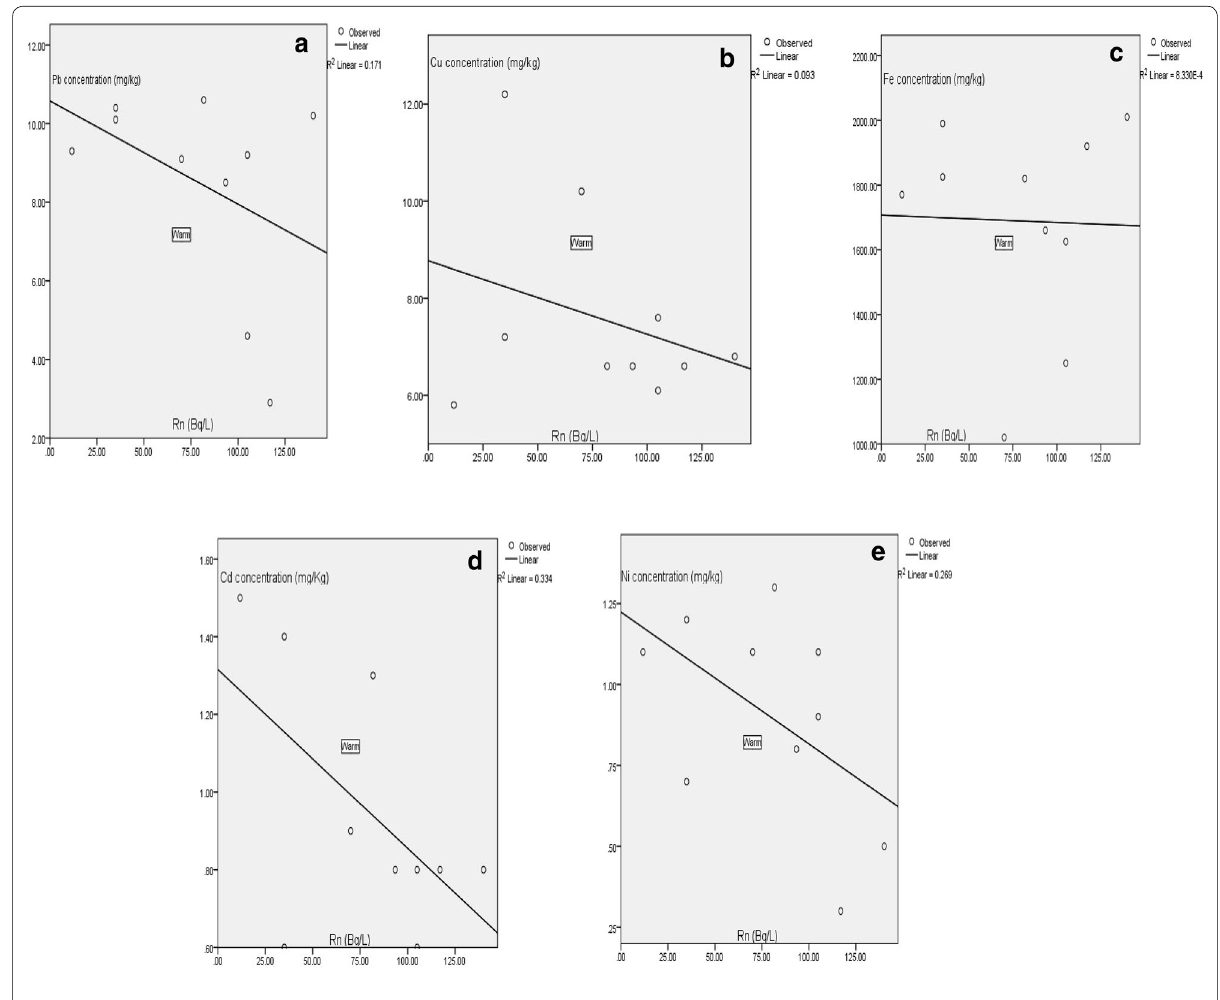
Fig. 4 a Pb vs Rn. b Cu vs Rn. c Fe vs Rn. d Cd vs Rn. e Cu vs